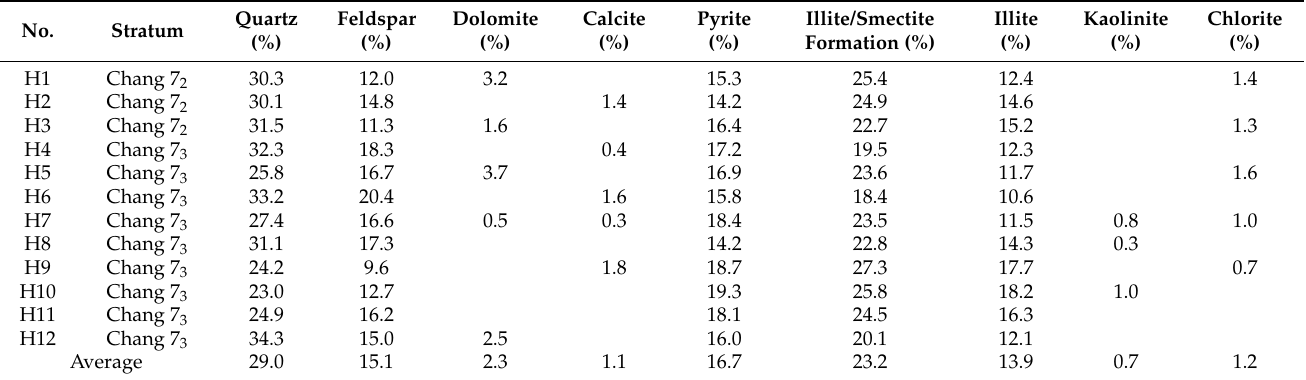
Table 3. The XRD analysis of the minerals from Chang 7 outcrop